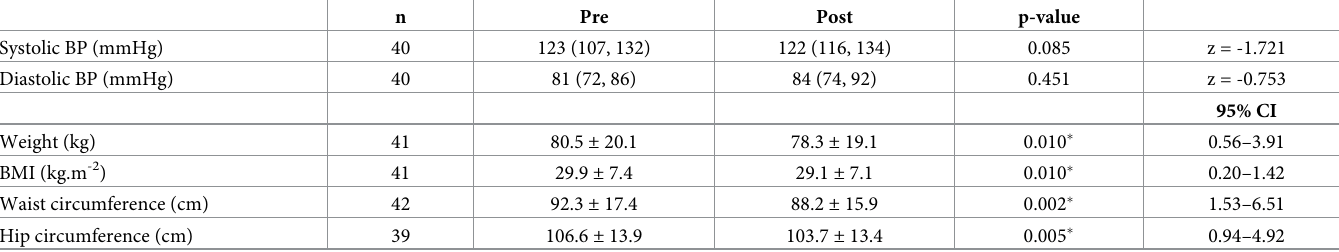
� Data presented as mean ± SD or median (IQR) for normally and not-normally distributed data, respectively. P-values shown for differences between pre and post- programme measurements. Significant at p < 0.05. z scores reported for non-parametric analyses; 95% confidence intervals reported for parametric analyses (difference between pre and post scores).